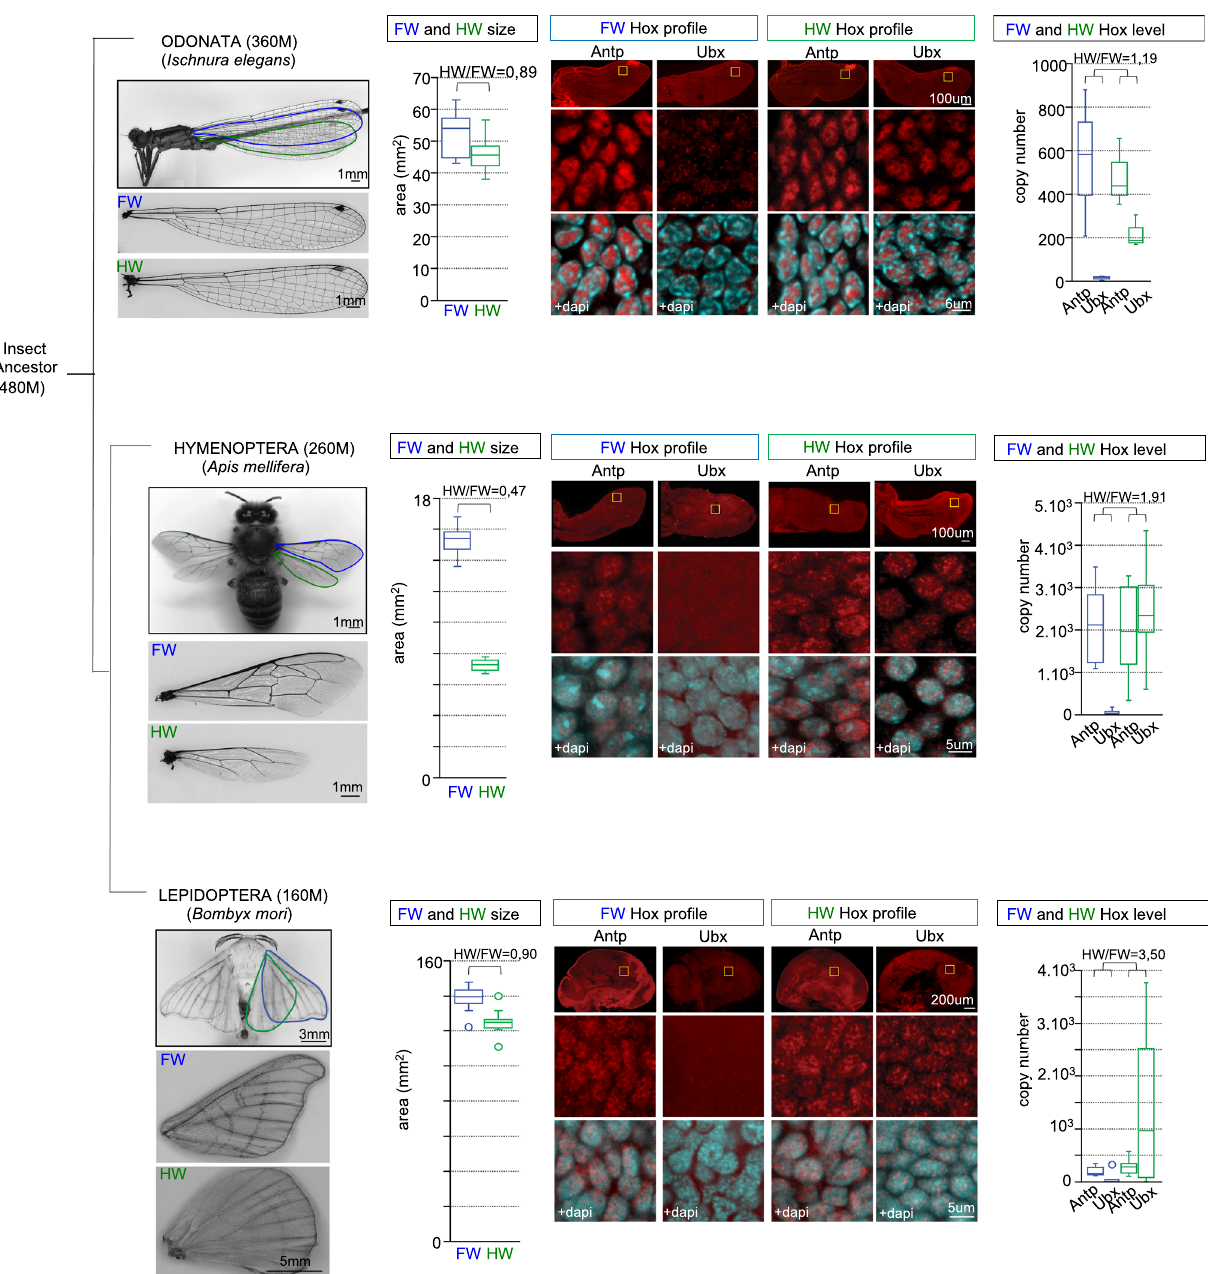
Fig. 8 Antennapedia (Antp) and Ultrabithorax (Ubx) are expressed in the fl ight appendage primordia of evolutionary distant insect species. Simpli fi ed insect evolutionary tree with illustrated pictures of insect species used in this study (the timescale is given in million (M) years). Individual forewings (FW, surrounded in blue) and hindwings (HW, surrounded in green) are shown below each adult species. Boxplots on the right show the quanti fi cation of the adult FW and HW area (minimum n = 10). The HW/FW ratio indicates the size difference between the two pairs of wings. Representative confocal images of the expression pro fi le of Antp and Ubx (in red) in the full FW and HW primordium (top), and in enlargements (yellow box) on few cells to better highlight the speci fi c nuclear staining (with nuclear DAPI co-staining in cyan). These patterns of fl uorescent immunostaining were systematically reproduced from three independent experiments ( n = 8 for I. elegans ; n = 10 for A. mellifera and n = 12 for B. mori ). Boxplots on the right show RT-qPCR quanti fi cation for Antp and Ubx mRNA from dissected FW and HW primordia of late nymph ( I. elegans , n = 12) and pharate pupa ( A. mellifera , n = 18) or from imaginal discs of fourth instar larva ( B. mori , n = 18). The HW/FW ratio indicated above each graph is calculated by considering the total Antp + Ubx mRNA expression level in each primordium. Boxplots indicate 25th and 75th percentiles, whiskers show ±1.5 × IQR and center line depicts median of three biological replicates. Statistical information . Statistical analyses were performed with Excel 2010 two-tailed t test with Welch ’ s correction was applied. All values are presented as mean± SD. The number of experiments and samples are indicated in the fi gure (Microsoft) and considered statistically signi fi cant at a p value < 0.05. When nor- legends. All pairwise comparisons were two-tailed. The investigators were not mality or equal variance between samples was achieved, an unpaired two-tailed t blinded to allocation during experiments and outcome assessment. test was used. When normality or equal variance of samples failed, an unpaired